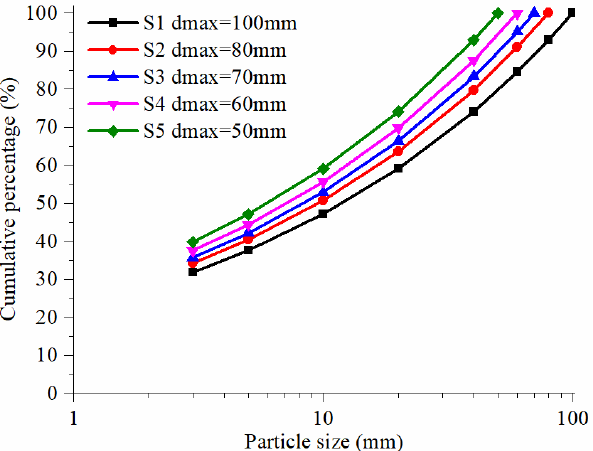
Figure 5. Predicted particle size distributions of SRM samples with different maximum particle diameters.